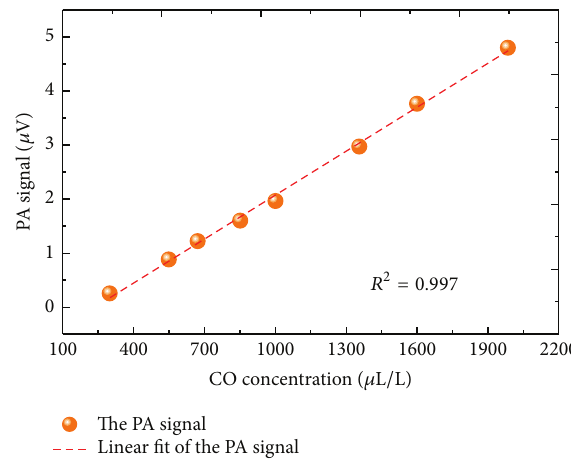
Figure 8: The PA signal versus laser power in the range of 3 to 14mW.